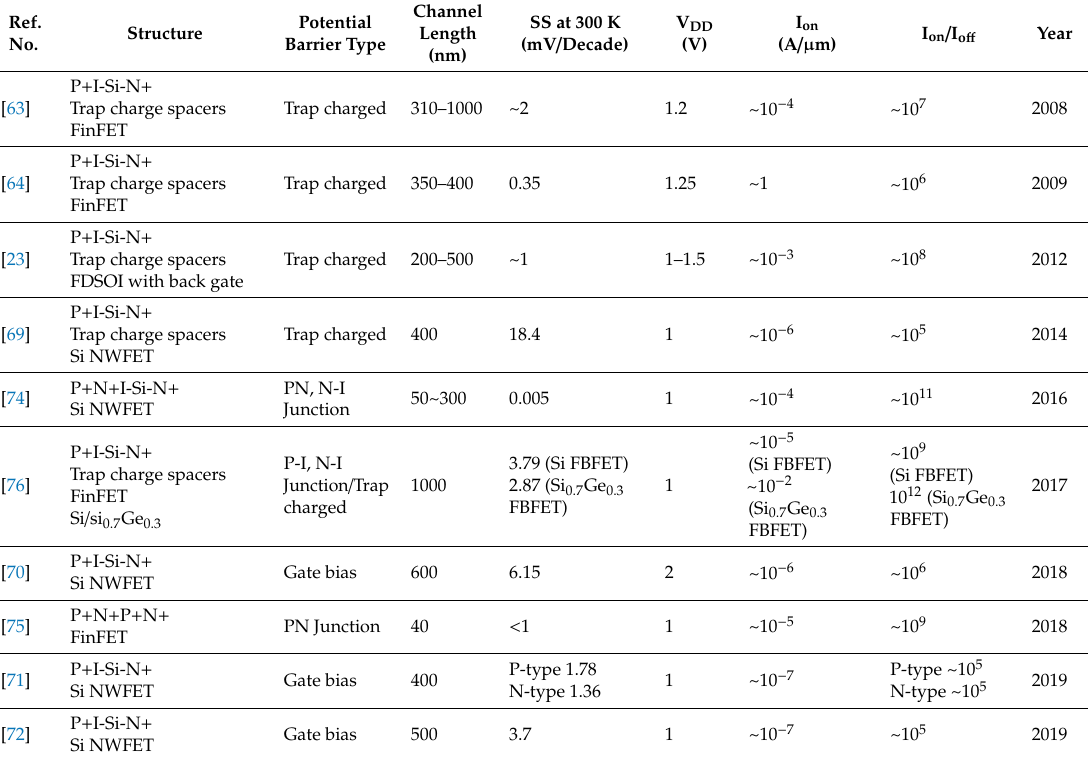
Table 1. Comparison of various FBFET